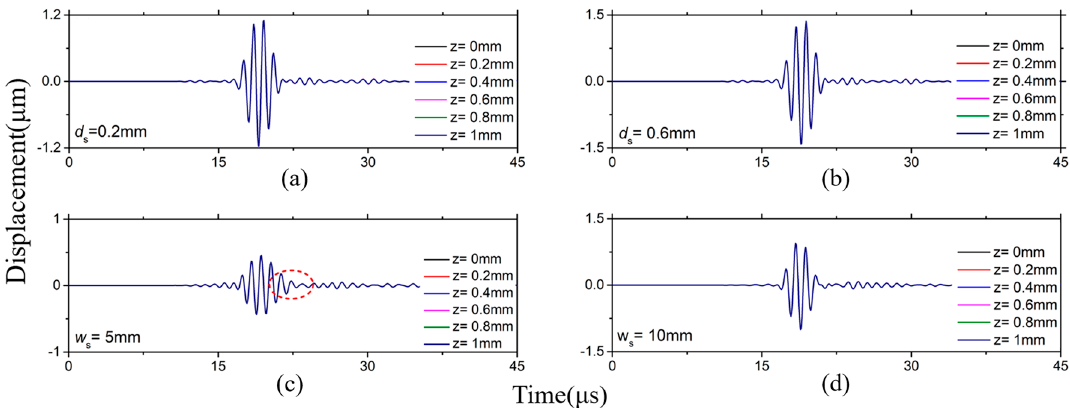
Figure 5. Waveforms in 1 mm thick waveguide bars: ( a ) w s = 25 mm, d s = 0.2 mm; ( b ) w s = 25 mm, d s = 0.6 mm; ( c ) w s = 5 mm, d s = 1 mm; ( d ) w s = 10 mm, d s = 1 mm.